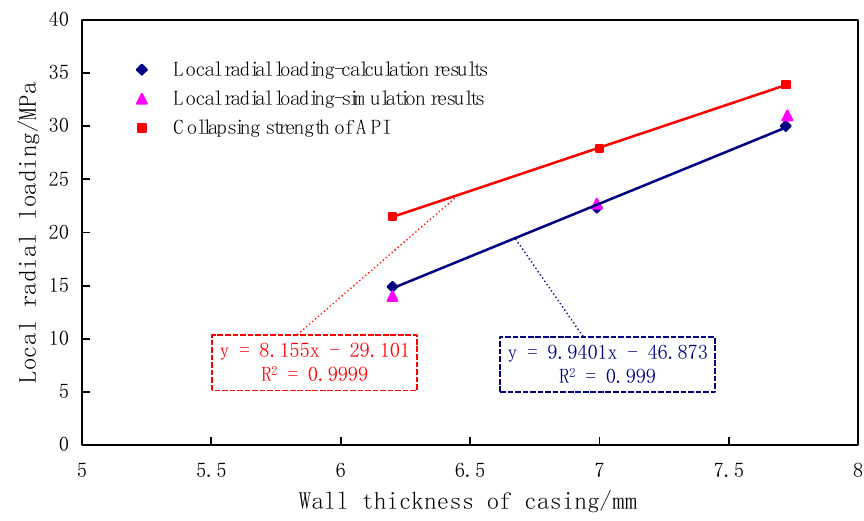
”J55-type casing. Figure 8. Calculation results of deformation on different wall thicknesses of 5½ ″ J55-type casing. 2